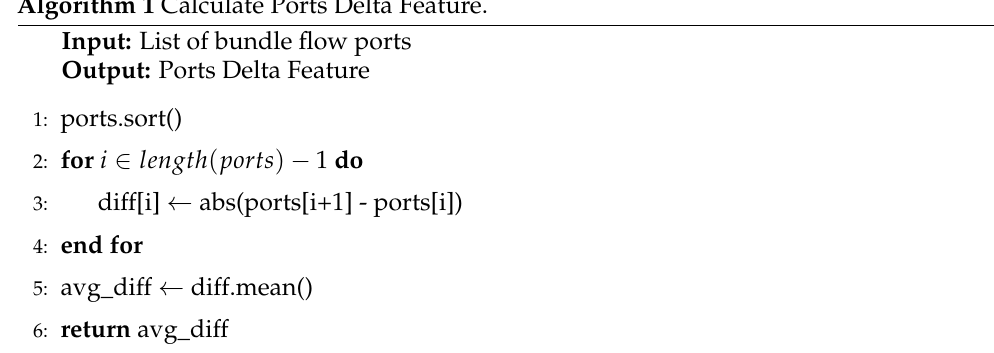
Algorithm 1 Calculate Ports Delta